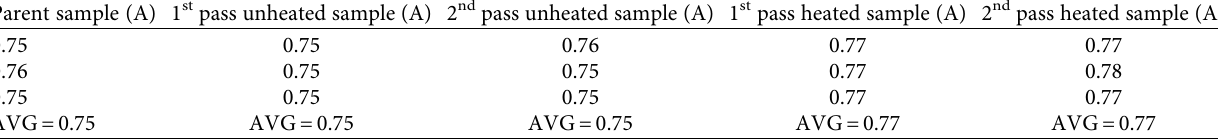
Table 6: Current results.